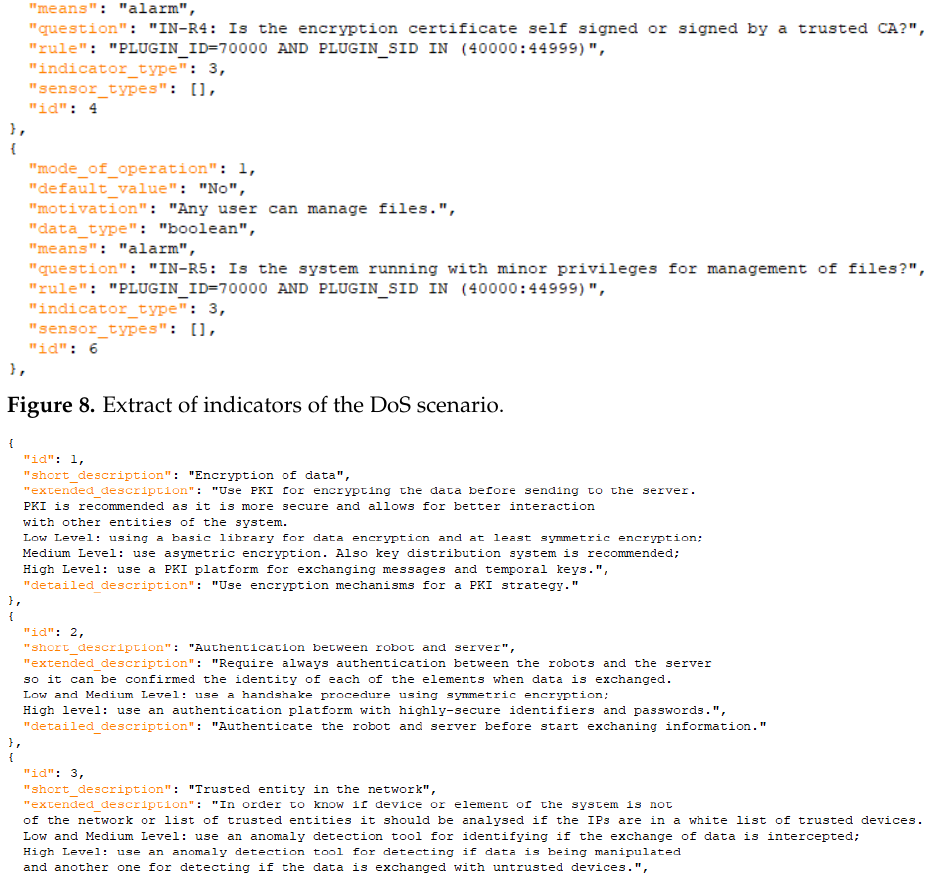
Figure 9. Extract of mitigations of the DoS